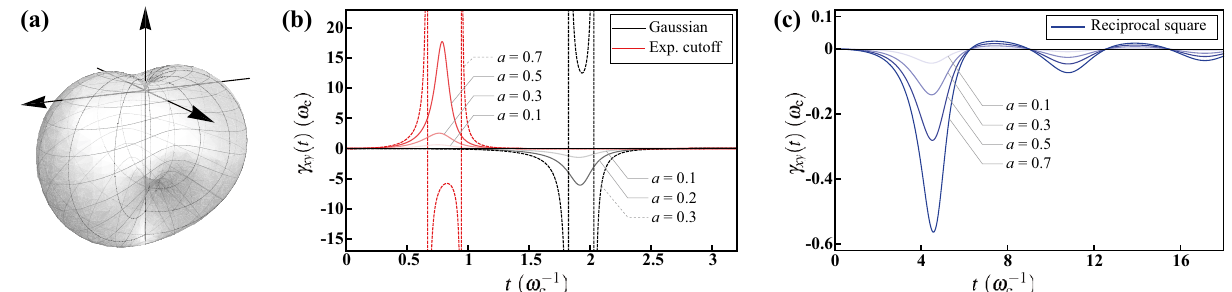
Figure 7. Decoherence under the HE with the geometry of kneaded cardioid. ( a ) Visualization of the solid ( 1 0.3 . The azimuthal symmetry cos θ)( 1 a cos 2 φ)/ 4 π with lateral asymmetry a angular part �(θ , φ) = = − + is broken due to the φ -dependence, and merely the simultaneous reflectional symmetries about the x - z and y - z planes are left. ( b ) The decay rate γ xy ( t ) for the Gaussian (black) and the exponential cutoff (red) radial functions with different lateral asymmetry a . As γ xy ( t ) is caused by the azimuthal symmetry breaking, it is gradually vanishing when a is decreasing and, contrarily, becomes more prominent for a more asymmetric geometry. 0.3 and 0.7 for As indicated by the dashed curves, the negative peaks even split into two singularities at a = Gaussian and exponential cutoff radial functions, respectively. ( c ) The decay rate γ xy ( t ) for the reciprocal square radial function with different lateral asymmetry a . Similar tendency toward vanishment with decreasing a can also be seen. However, for the reciprocal square, γ xy ( t ) do not exhibit singularity even if under large